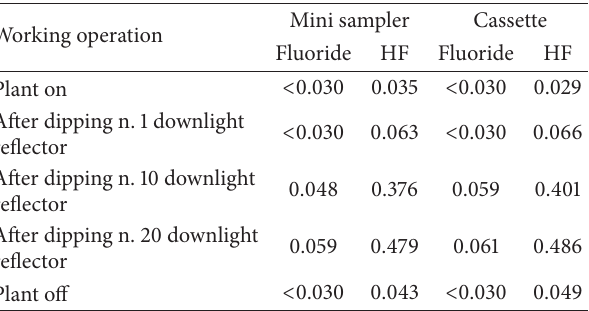
Table 3: HF concentration (mg/m 3 ) measured in an Italian company during the superbrightening of aluminium surfaces of downlight reflectors (sampling time: